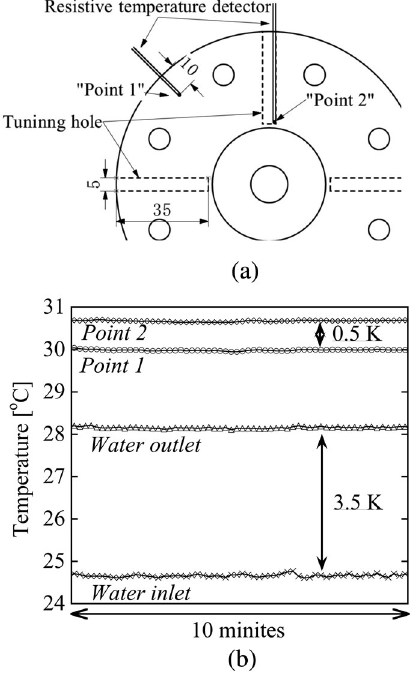
FIG. 14. (a) Schematic view of the measurement points where the resistive temperature detectors are located in the middle cell of the accelerating structure. (b) Temperature trends at “ Point 1 ” and “ Point 2 ” of the accelerating structure as well as the trends at the inlet and outlet of the cooling water when the acceleration gradient was 50 MV =